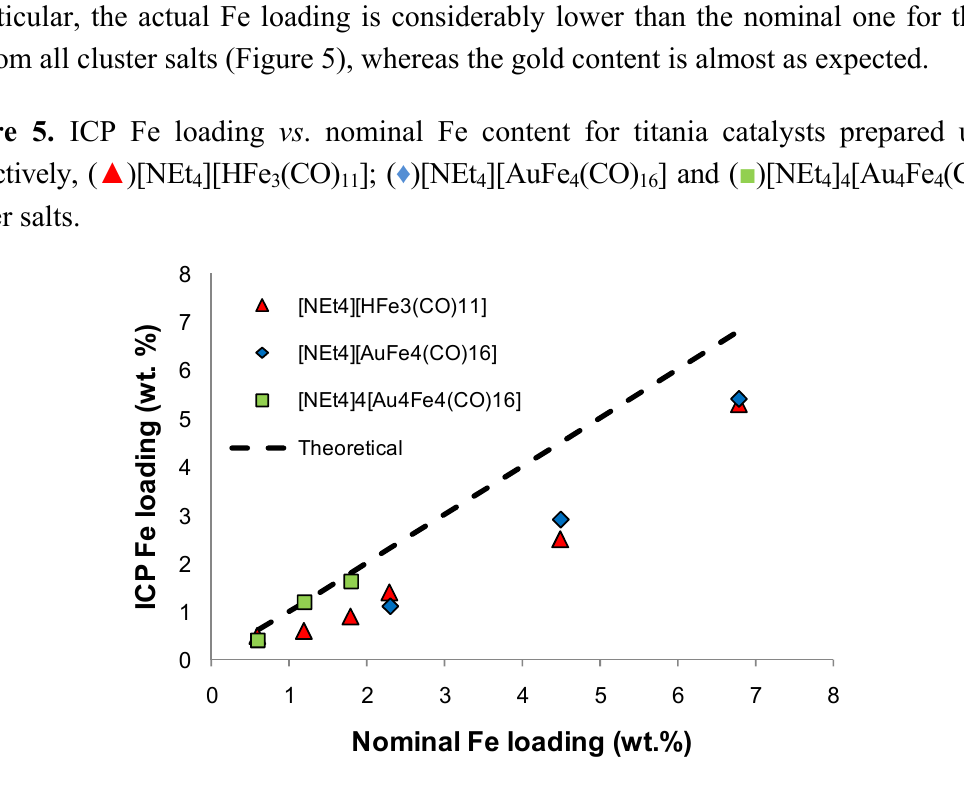
Table 1. Surface area and Au crystal size for Fe treatment temperature.